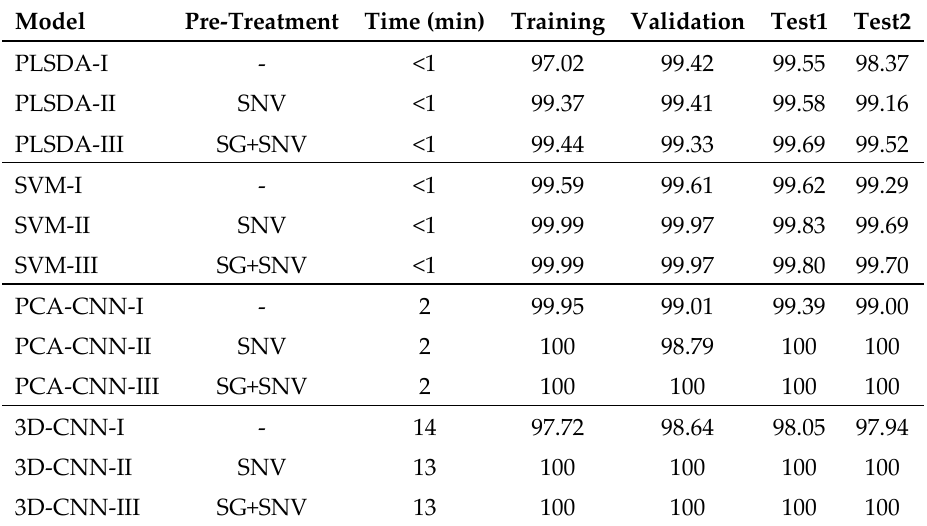
Table 1. Model performance of sweet samples for validation and test images in terms of % correct classification rate